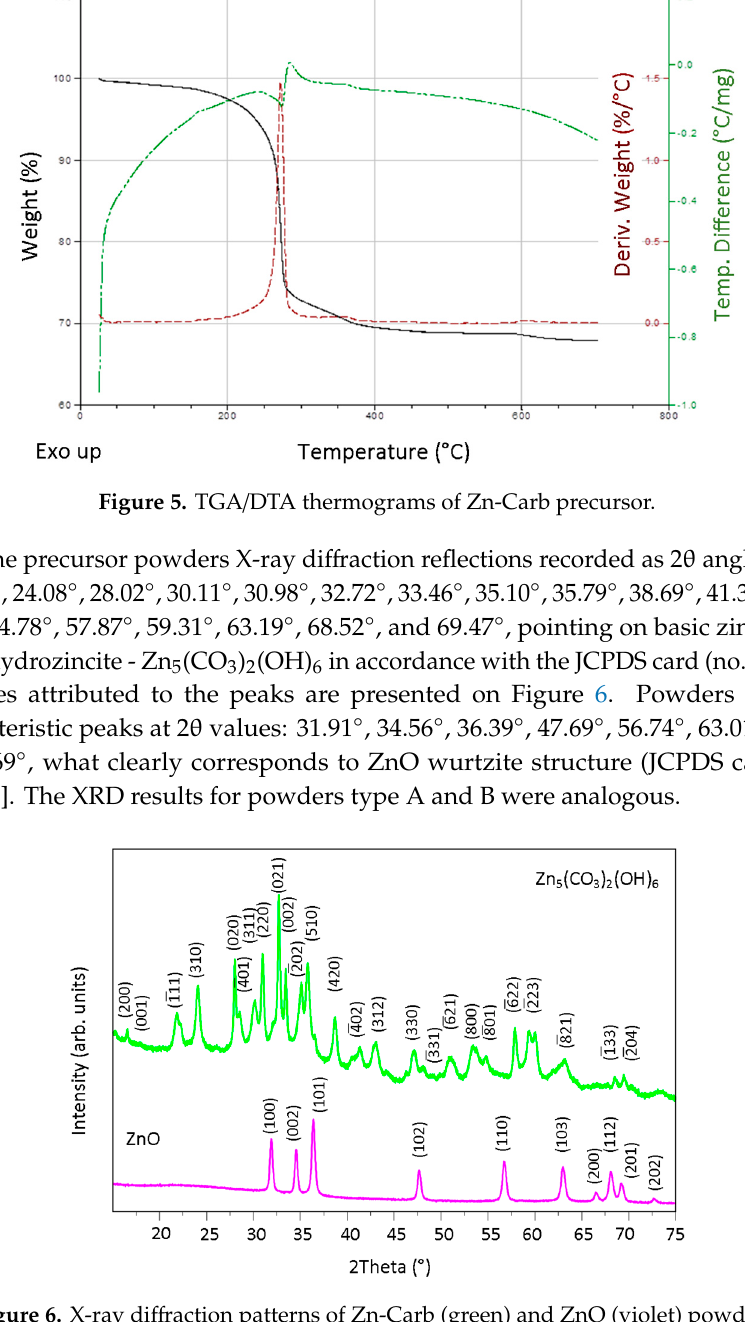
6 of 17 Figure 4. SEM micrographs of ZnO powders A type ( a , b ), B type ( c ) and intermediate forms ( d ). Thermal analysis measurements were carried out for the precursor obtained in non-typical synthesis, but with higher amount of PVP mass (0.5 g). The TGA/DTA curves of the precursor (Figure 5) indicates ca. 32% total weight loss in the calcination process. The first endotherm is observed in the range 25–295 °C (26.7% weight loss), while the second one between 295–490 °C (4.1% weight loss), and the third in the range 590–700 °C (0.9% weight loss). It would be difficult unambiguously identify the decomposition products in each stage due to the similar decomposition temperatures of the precursor and PVP. The amount of polymer present on the surface of precursor can be only estimated. Calculated weight loss during basic zinc carbonate decomposition process is 25.9% and corresponds